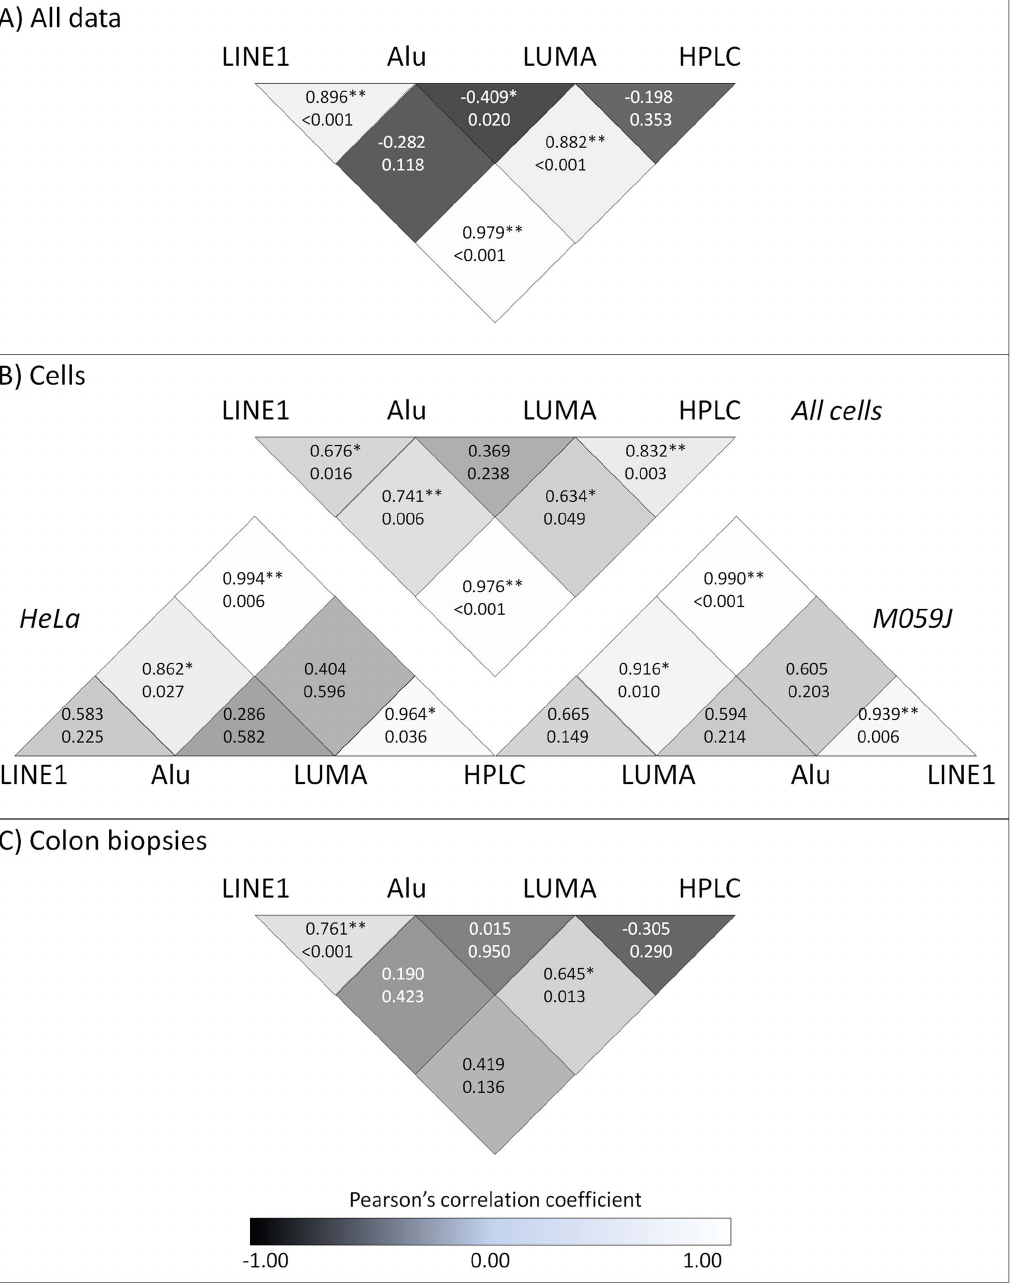
Figure 4. Correlation coefficients for the estimates of global DNA methylation as quantified by the various methods . A) Pearson correlations for all data combined (n=32), B) Pearson correlation coefficients when using the data from the cells (n=6/cell type), and C) Pearson correlations for the data from the colon biopsies (n=20).